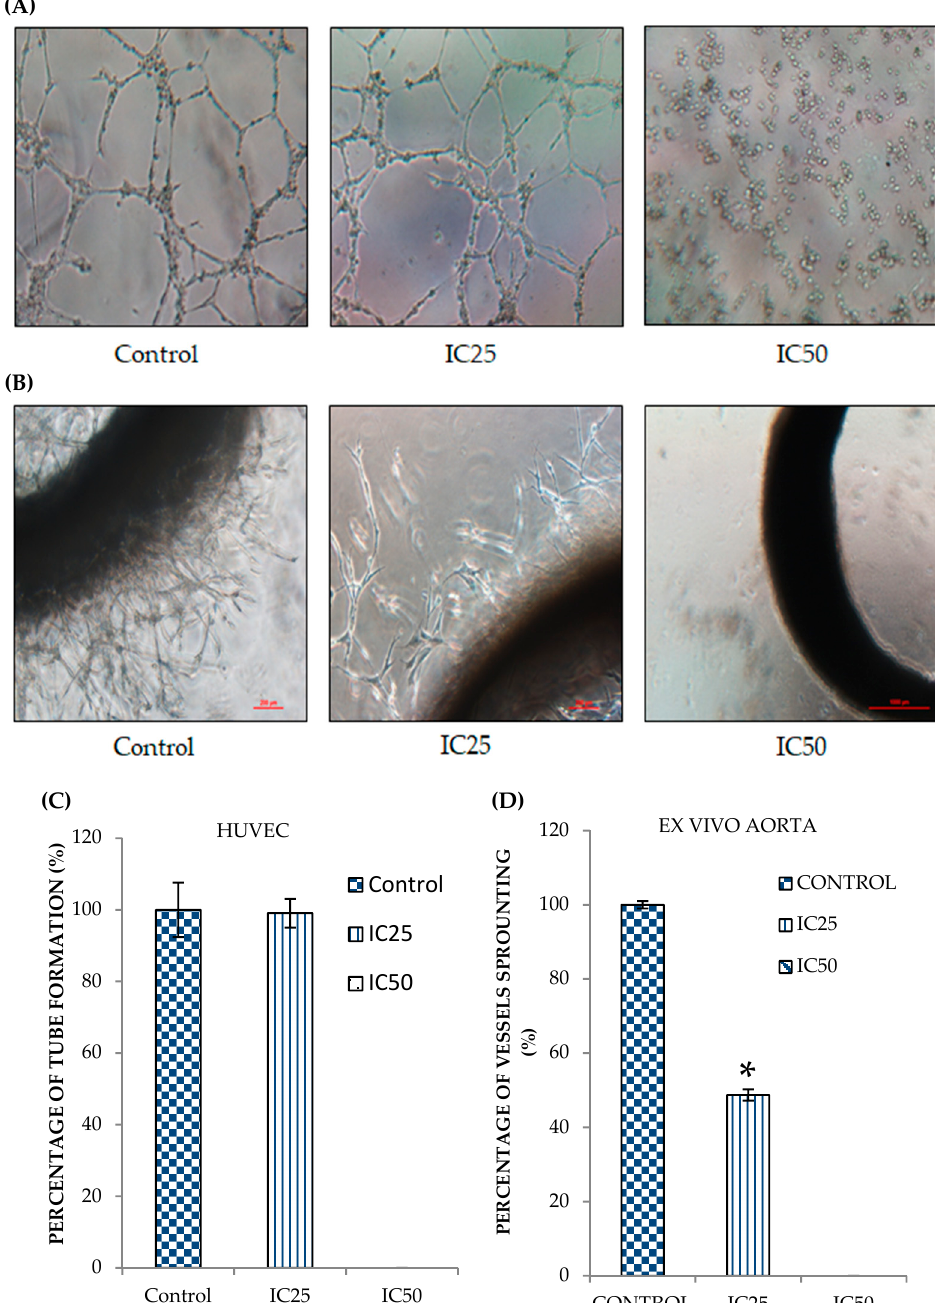
Figure 3. Curcumin analog DK1 inhibits the tubes formation as well as the micro-vessels sprouting; ultimately served as potential evidence as anti-angiogenic agent. ( A ) Images represent HUVEC tube formation assay when treated with two different concentrations (IC 25 , IC 50 ) of DK1 (Magnification: 100 ×). ( B ) Images of ex vivo rat aorta ring assay when exposed to two different concentrations (IC 25 , IC 50 ) of DK1 (Magnification: 100×). ( C ) Percentage of tubes formation when treated with two different concentration of DK1. ( D ) Percentage of micro-vessels sprouting of ex vivo rat aorta when treated with two different concentrations of DK1. Both experiments were done in triplicate and all data were expressed as mean ± standard error mean (S.E.M). * p < 0.05 comparing with corresponding control.